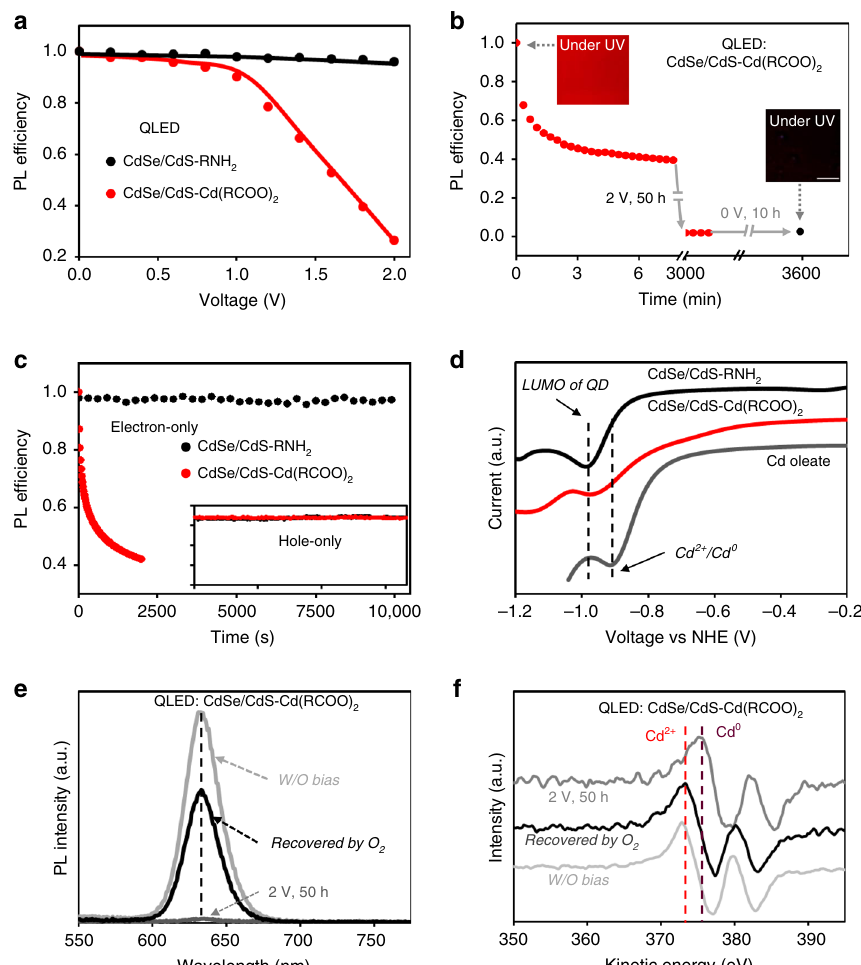
Fig. 2 Operando electrochemical reduction of the CdSe/CdS-Cd(RCOO) 2 QDs. a Relative PL ef fi ciency of the QDs in the QLEDs as a function of the driving voltage. b Relative PL ef fi ciency of the CdSe/CdS-Cd(RCOO) 2 QDs in a QLED (driven at a constant voltage of 2 V for 50 h, followed by 0 V for 10 h). Insets are the corresponding photographs of the devices under ultraviolet irradiation (scale bar: 0.5 mm). c Relative PL ef fi ciency of the QDs in electron-only devices (ITO/2,2 ’ ,2 ” -(1,3,5-Benzinetriyl)-tris(1-phenyl-1-H-benzimidazole) (TPBi, ~25 nm)/QDs (~40 nm)/Zn 0.9 Mg 0.1 O (~60 nm)/Ag, driven at a constant current density of 10 mA cm − 2 ). Inset, the relative PL ef fi ciency of the QDs in hole-only devices (ITO/PEDOT:PSS (~35 nm)/poly-TPD (~30 nm)/PVK (~5 nm)/QDs (~40 nm)/4,4 ′ -Bis(N-carbazolyl)-1,1 ′ -biphenyl (CBP, ~25 nm)/MoO x /Au) sharing the same coordinate axes with the main plot. The hole-only devices are driven at a constant current density of 30 mA cm − 2 to ensure that only holes and no electrons are injected into the devices. d , The voltammetric curves of the two types of CdSe/CdS core/shell QDs and cadmium oleate. e and f , PL and differential auger electron spectra of the CdSe/CdS-Cd(RCOO) 2 QDs in QLEDs under different conditions. The top electrodes are delaminated by adhesive tapes and the oxide electron- transporting layers are etched by a dilute acetonitrile solution of acetic acid, a known inert solution for the QD